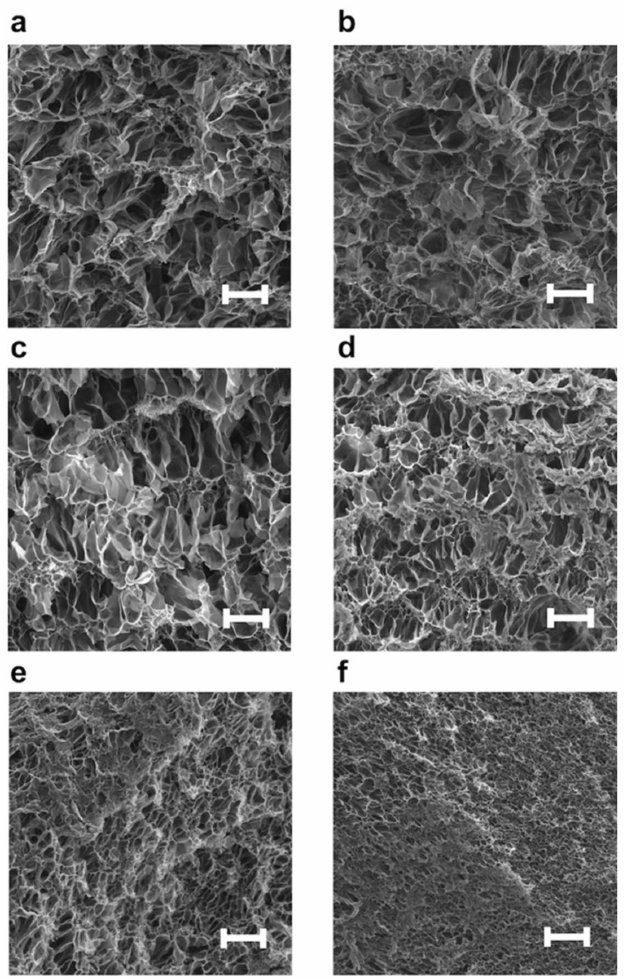
Figure 6. SEM images of PAAm and NC hydrogels containing PImQ/graphene. ( a ) H0.05, ( b ) G0.2H0.05, ( c ) G0.5H0.05, ( d ) G1H0.05, ( e ) G2H0.05, ( f ) G3H0.05. Scale bars are 20 µ